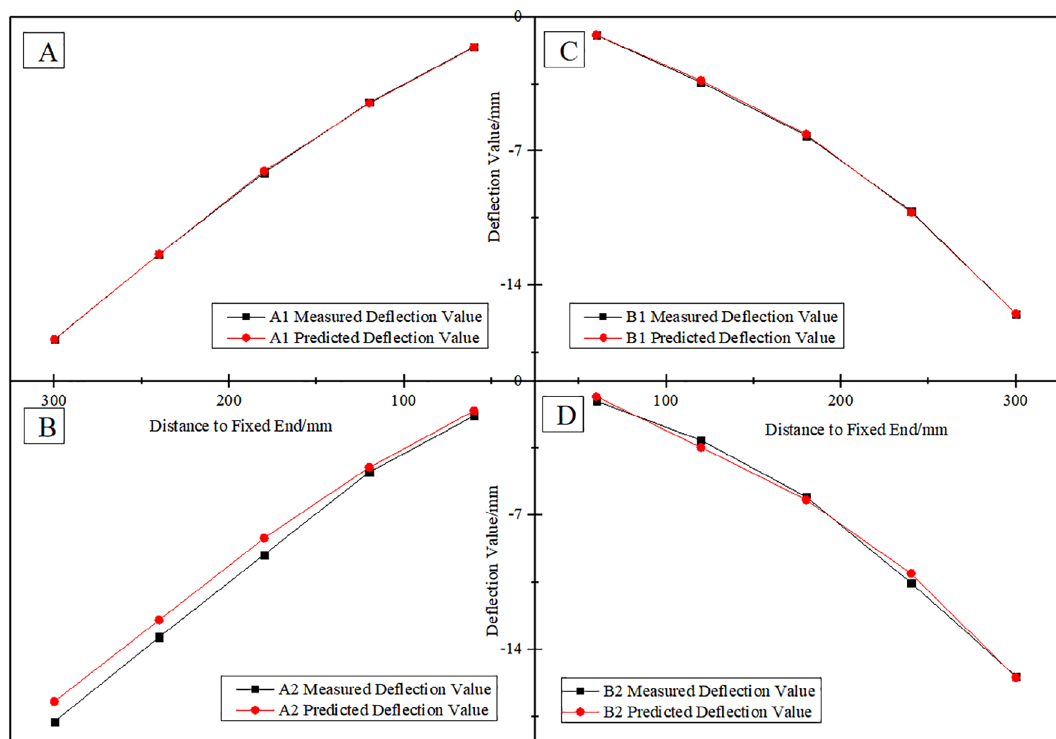
Figure 6. Curve Fitting Diagrams of Actual Measured Deflection Value and Predicted Deflection Value of the Test Pieces. A~D Fitting Diagram of Test PieceA1 、 A2 、 B1 、 B2,respectively output value of the test piece was used to evaluate the error between the two. The calculation formula of RMS is as shown in Equation